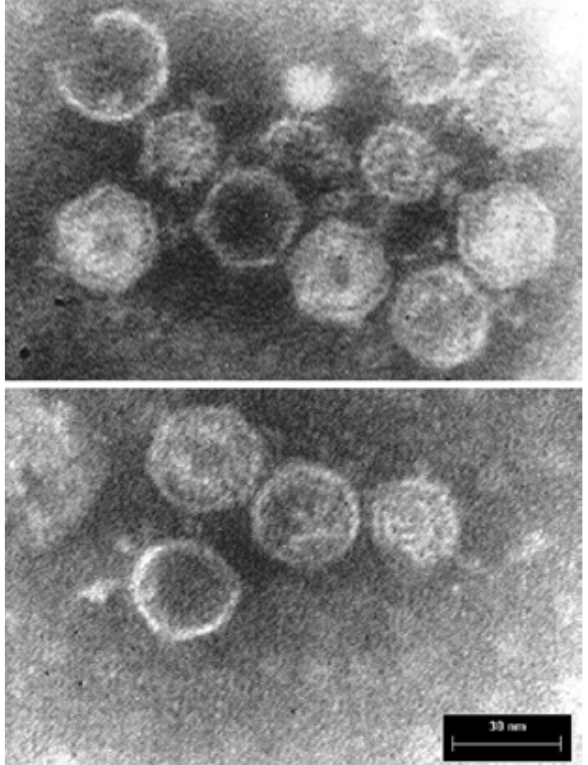
Figure 7. Icosahedral virus-like particles with diameters of approximately 28 nm and observed only in MI